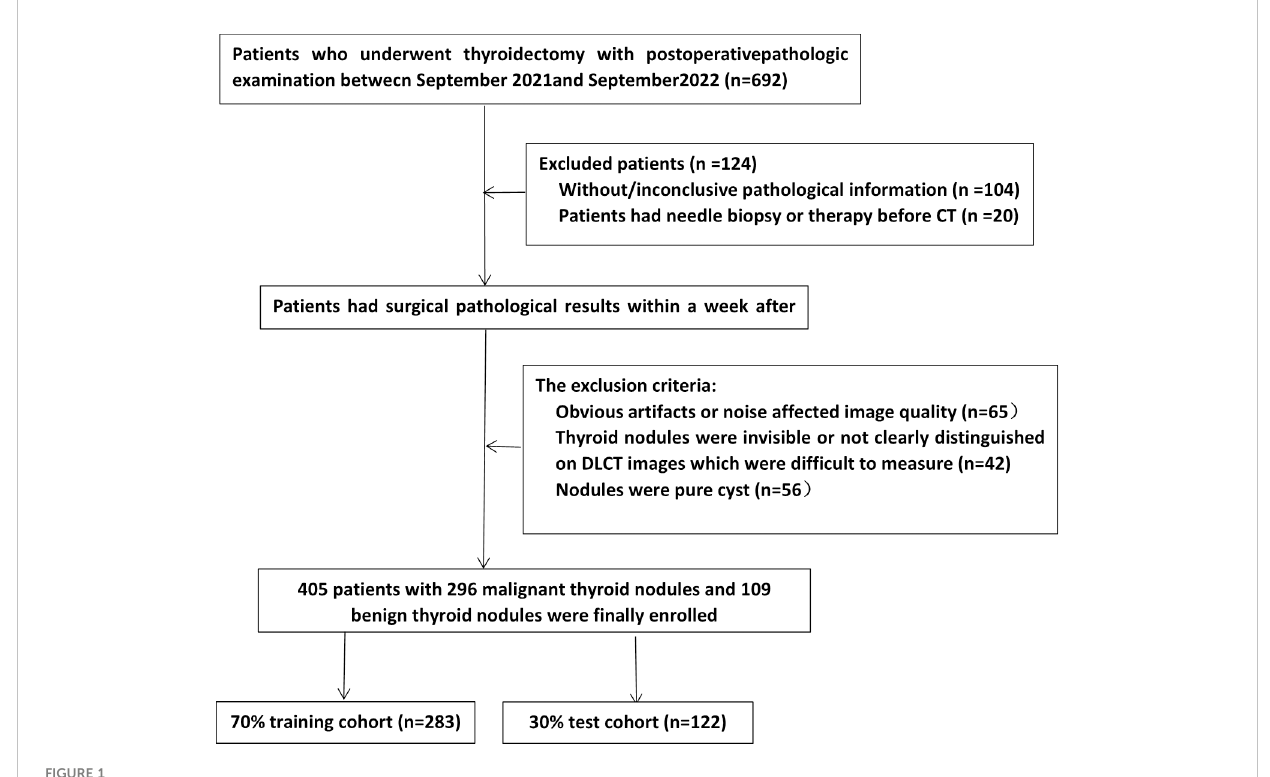
FIGURE 1 Flowchart showing the screening strategy for patients in this